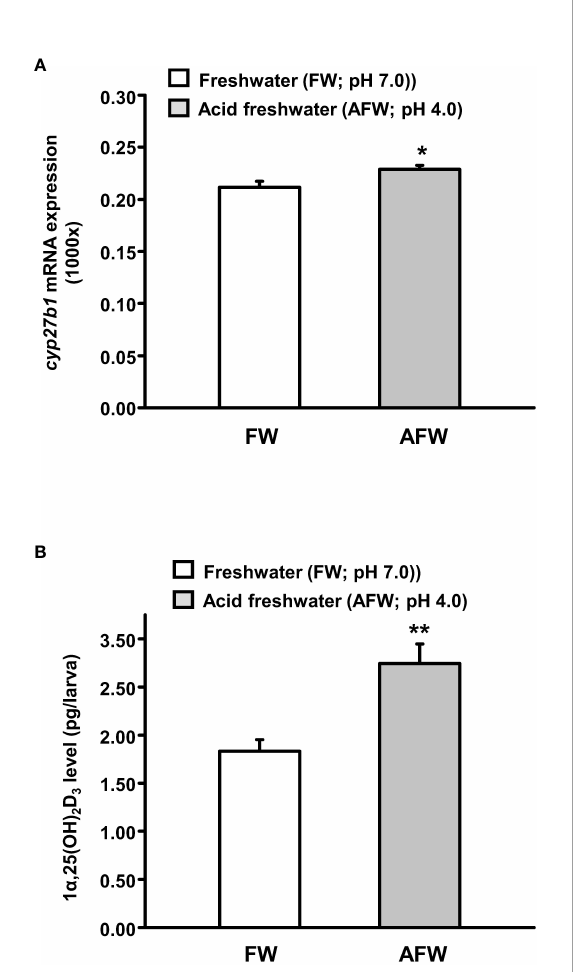
FIGURE 1 Effects of freshwater (FW, pH 7.0) and acidic freshwater (AFW, pH 4.0) on (A) the mRNA expression of cyp27b1 and (B) whole body 1 a , 25-dihydroxyvitamin D 3 (1 a ,25(OH) 2 D 3 ) level in 3 days post- fertilization (dpf) zebra fi sh larvae. The mRNA expression was analyzed by qPCR, and the values were normalized to b -actin. Values were expressed as the mean ± SEM (n = 6). Student ’ s t- test, * p < 0.05; ** p <